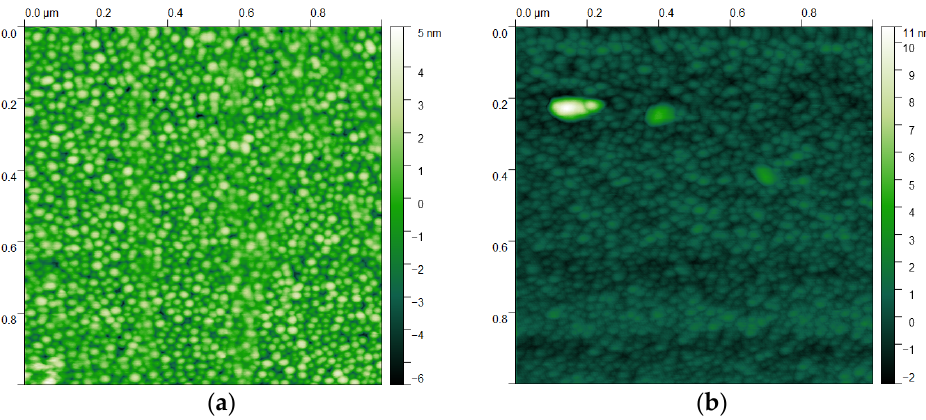
Figure 5. Cross ‐ sectional SEM micrograph of the SMR stack.